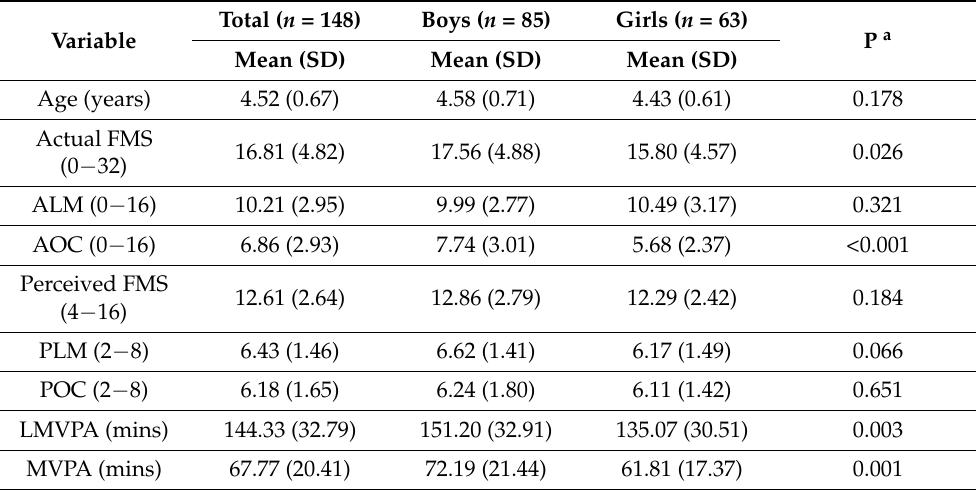
Table 1. Descriptive statistics for children’s age, physical activity (PA), perceived and actual FMS and sex differences.